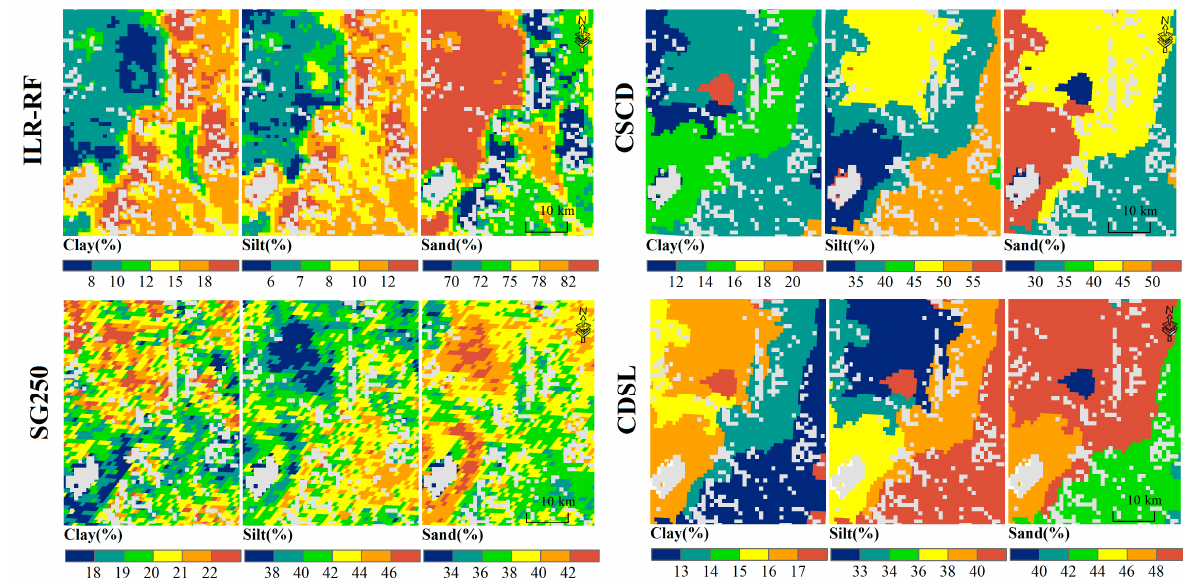
Figure 6. Spatial distribution of soil particle size fractions (PSFs) at the BQ region using isometric log-ratio (ILR)-random forest (RF) and extracted from three soil datasets.